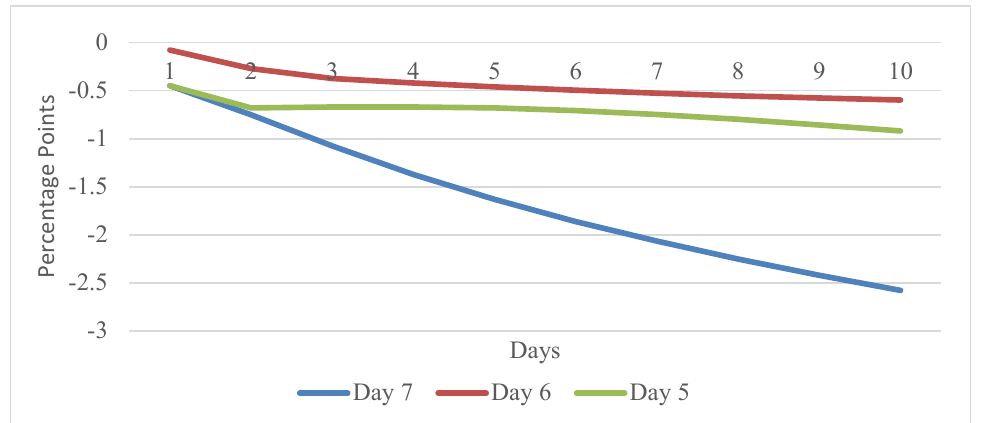
Fig. 9. Responses of unemployment rate to shocks at the end of the